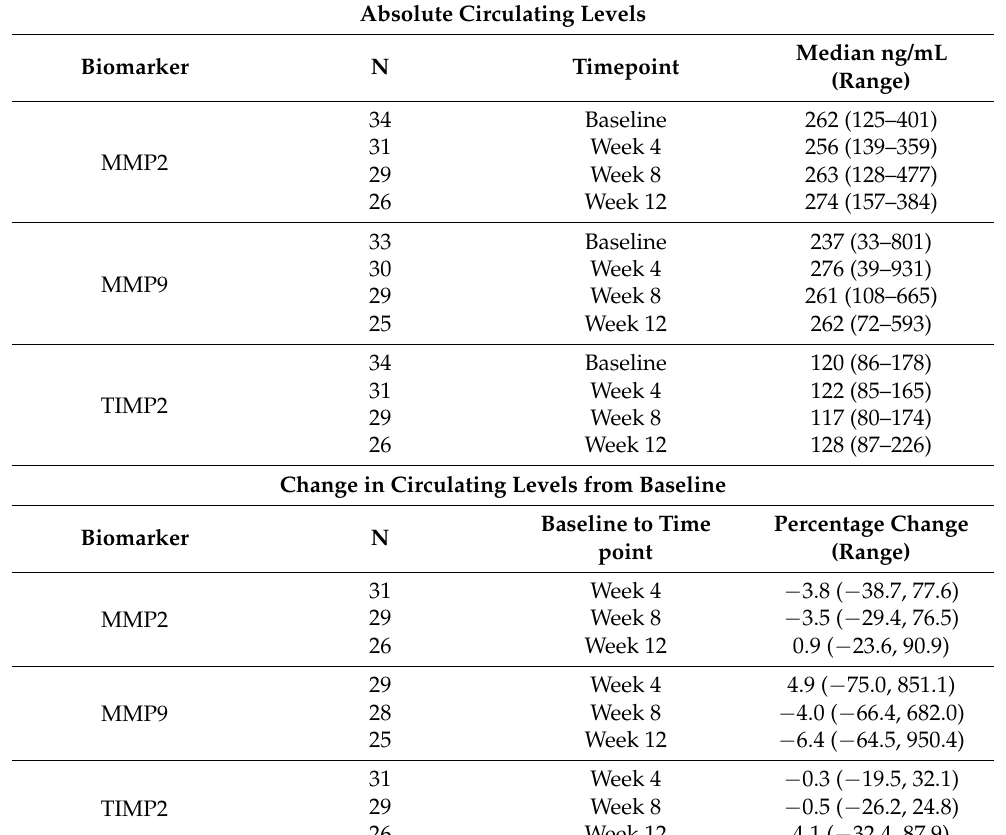
Table 2. Circulating levels of putative biomarkers.